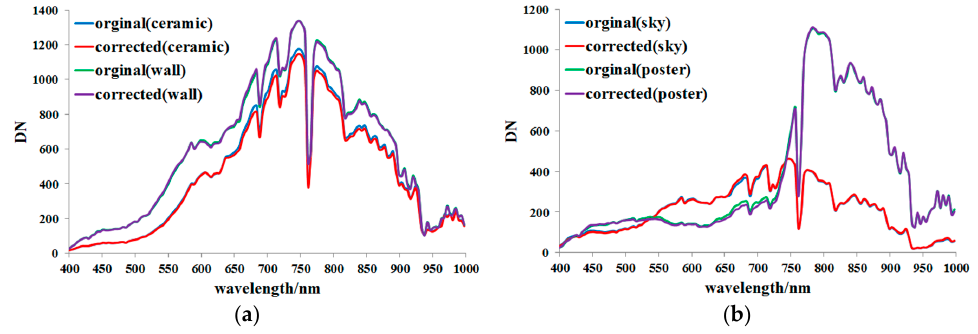
Figure 17. Comparison between the original spectra and the spectra corrected using the proposed method. ( a ) Ceramic and wall; ( b ) sky and poster.